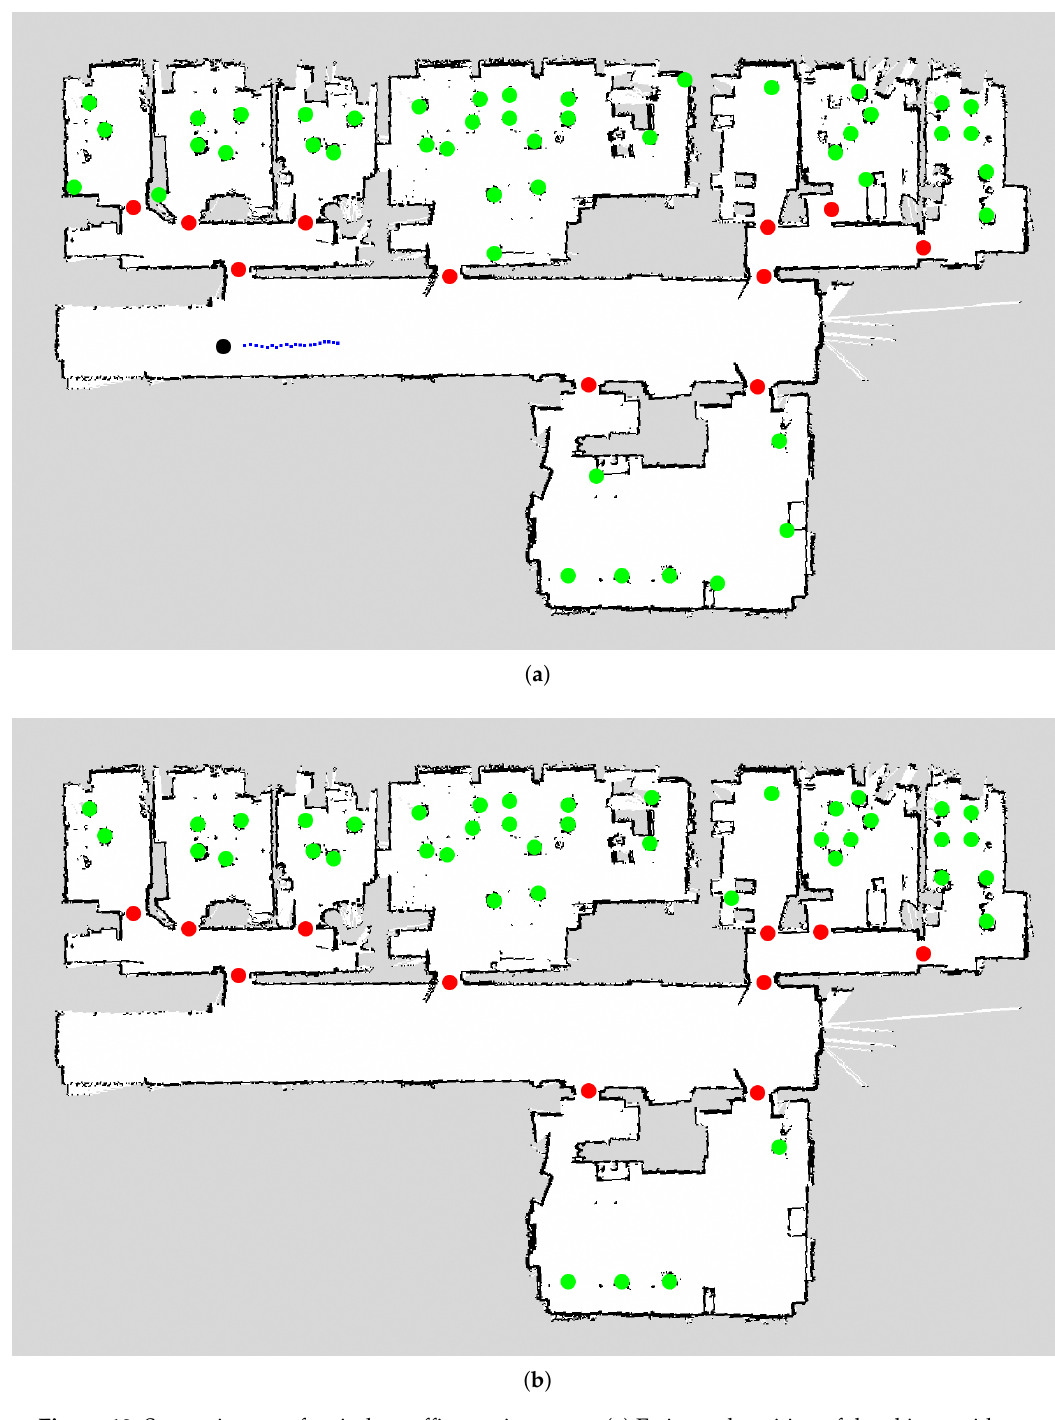
Figure 10. Semantic map of an indoor office environment. ( a ) Estimated position of the objects with our method; ( b ) real position of the objects in the scenario. The semantic information included are doors (red points), chairs (green points), and people (blue squares). The black dot was the actual starting position of the moving